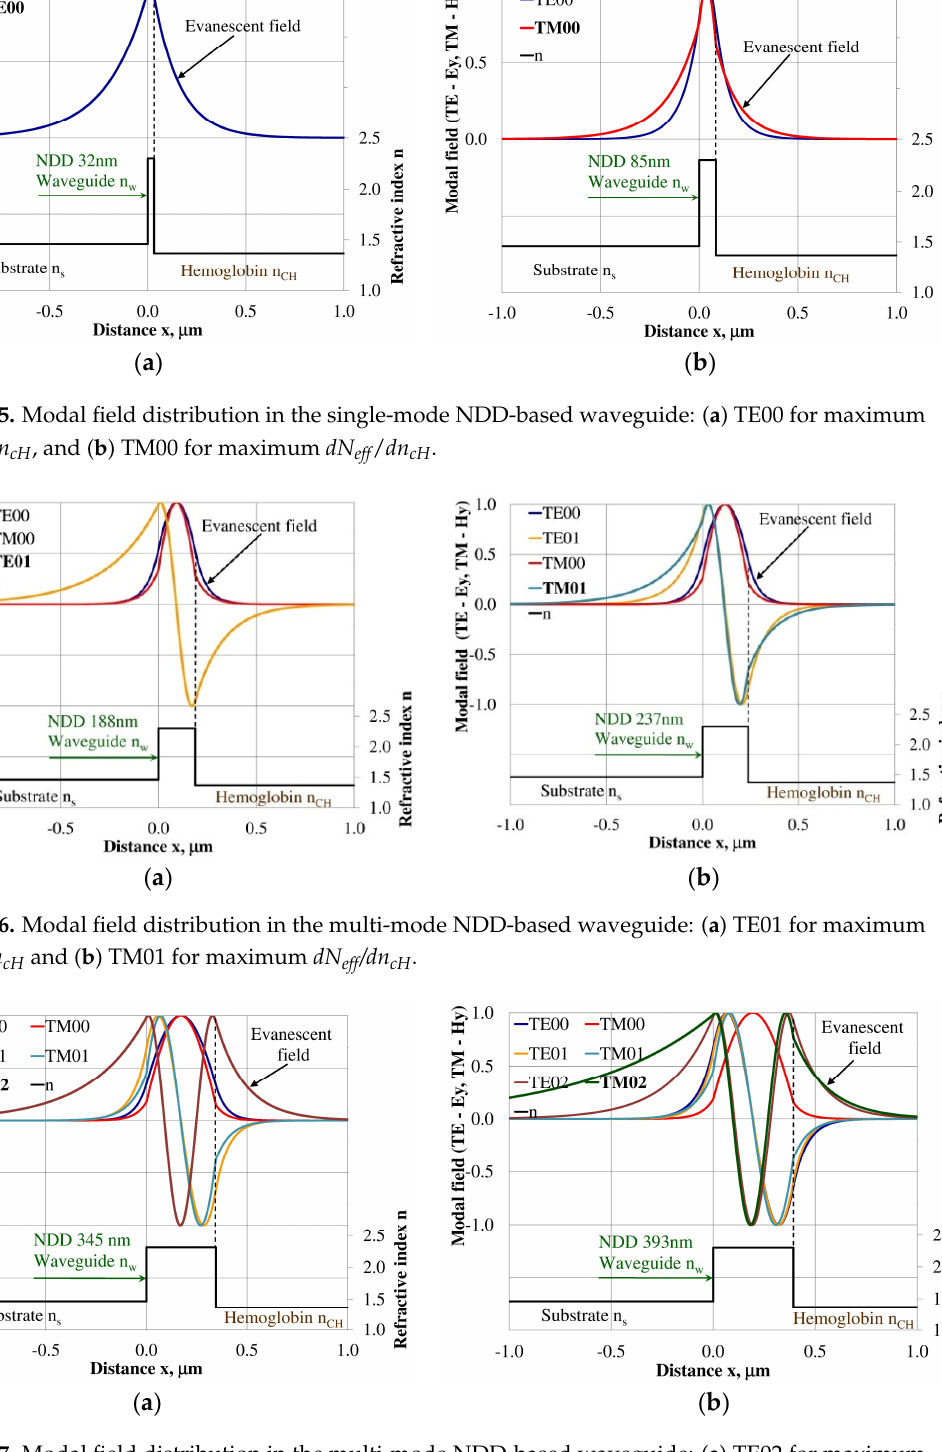
Figure 7. Modal field distribution in the multi-mode NDD-based waveguide: ( a ) TE02 for maximum dN eff /dn cH , and ( b ) TM02 for maximum dN eff /dn cH .